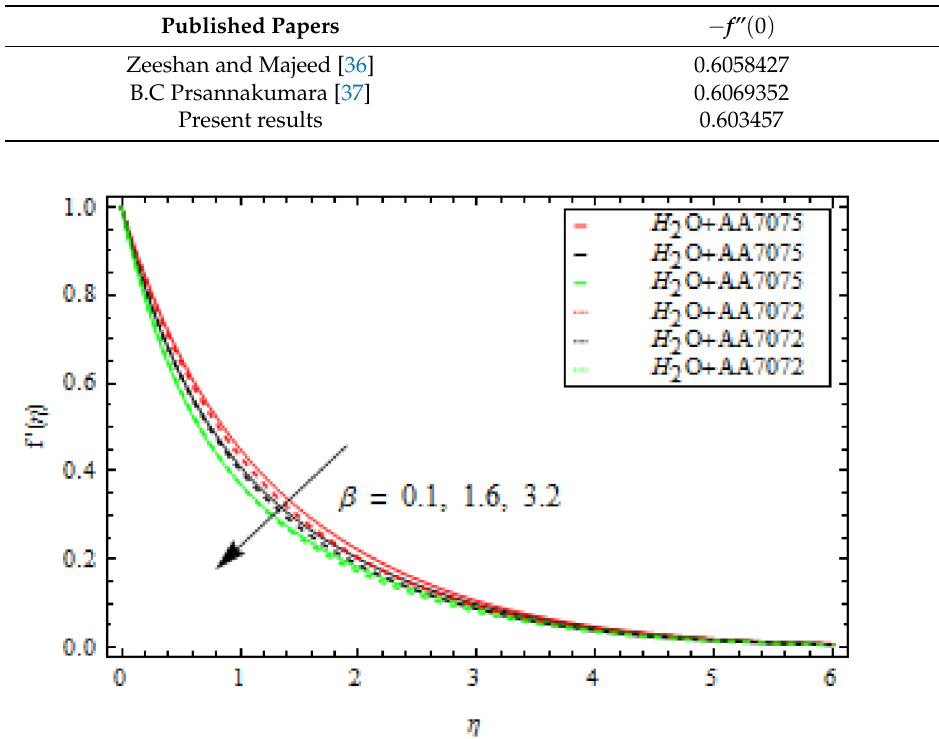
Figure 5. Influence of ferromagnetic interaction parameter β on velocity profile.